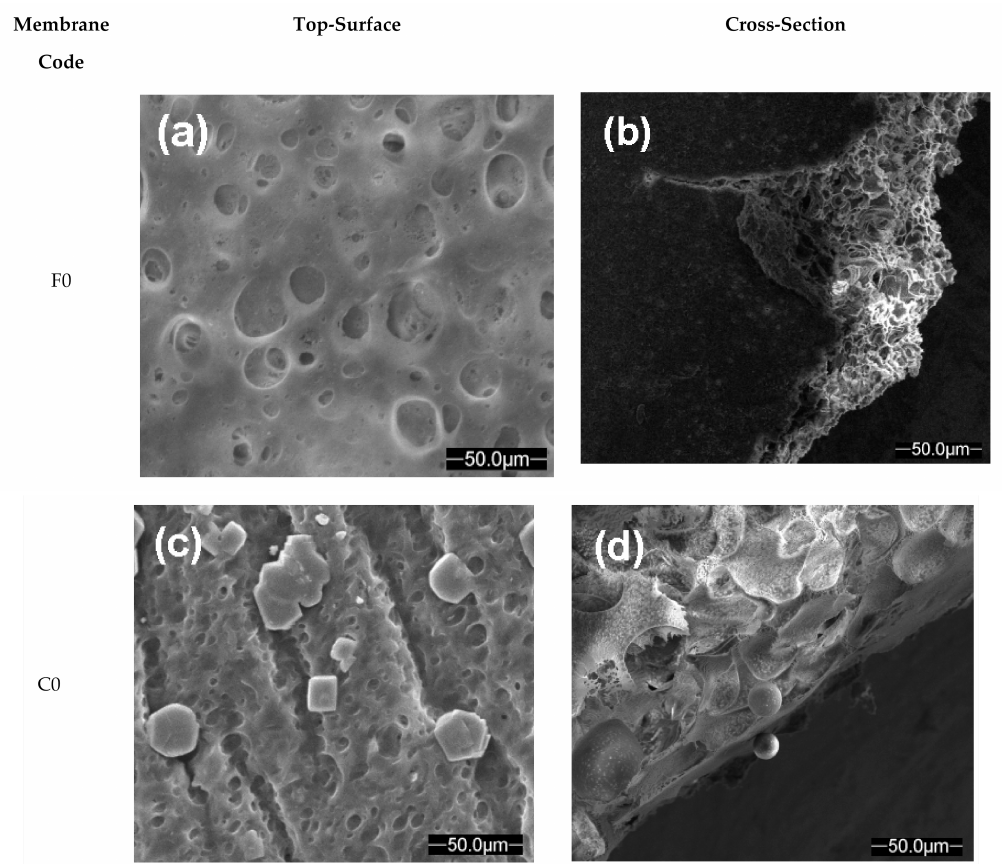
Figure 6. SEM images of polymeric membranes (without and with SiO 2 nanoparticles): F0, top-surface ( a ) and cross-section ( b ); C0, top-surface ( c ) and cross-section ( d